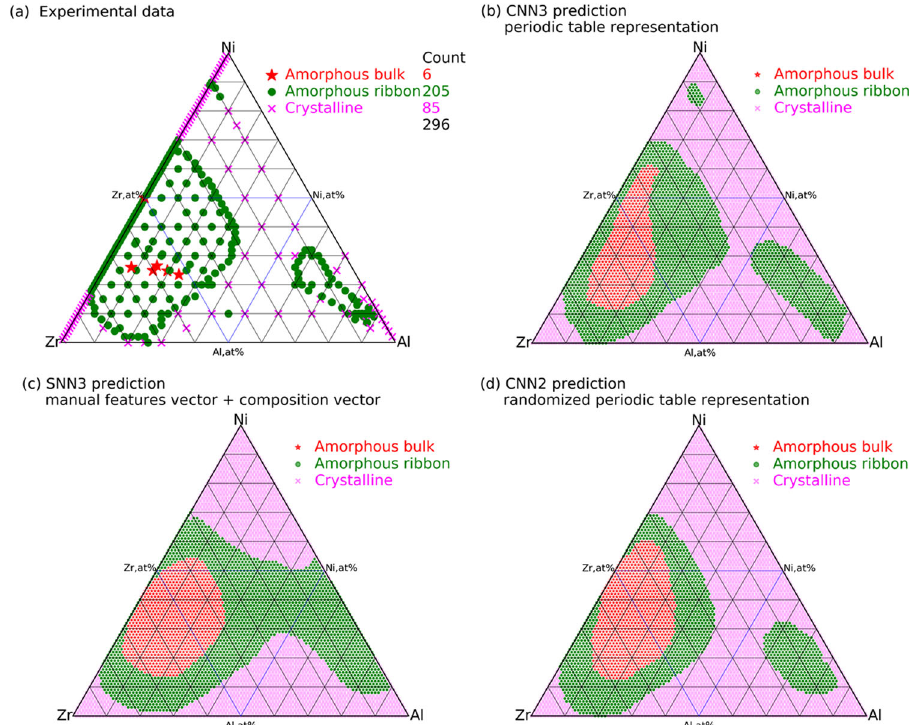
Fig. 3 Comparison of experimental data and predictions. a Experimental data points of Al – Ni – Zr ternary system in our dataset and the predictions of b CNN3, c SNN3, and d CNN2.